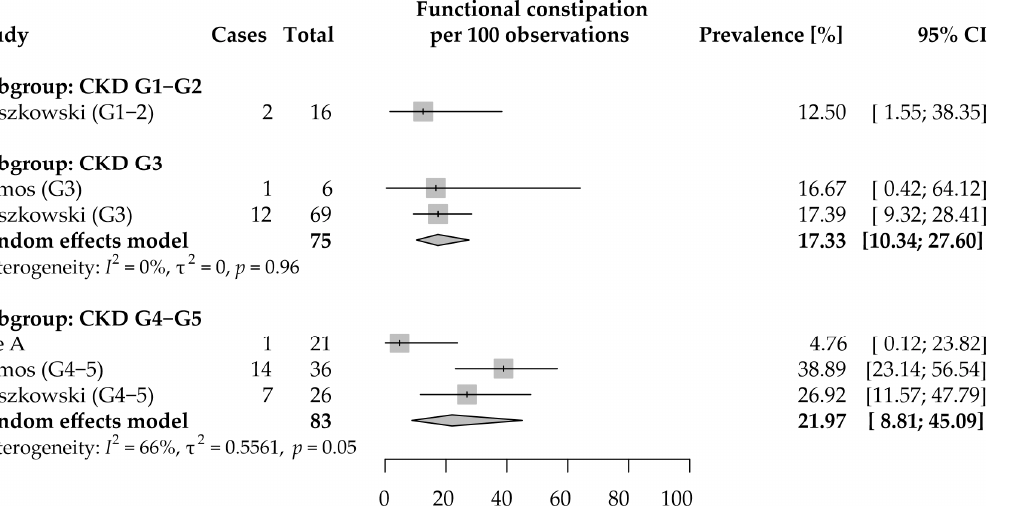
Figure 3. Forest plot with pooled point prevalence estimates for functional constipation in chronic kidney disease by stages.